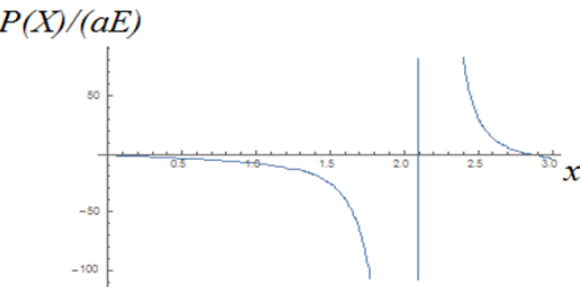
Figure 6: The distribution of body forces in the Λ -space with respect to the initial x